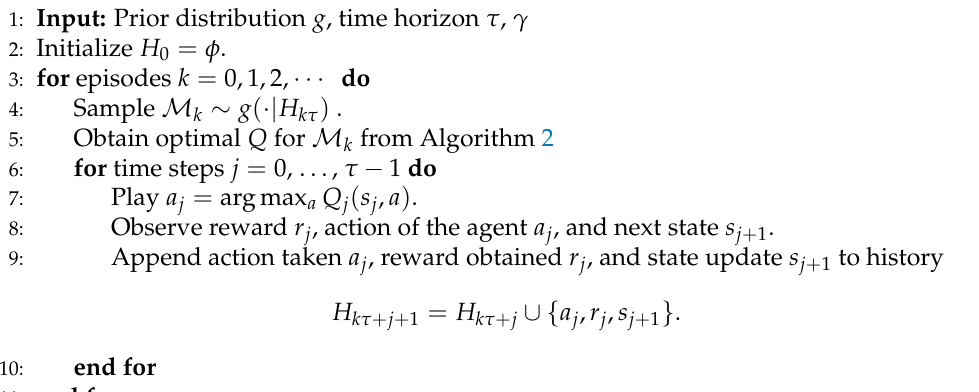
Algorithm 1 Proposed Algorithm for Mean-Field Game with Best Response Learning